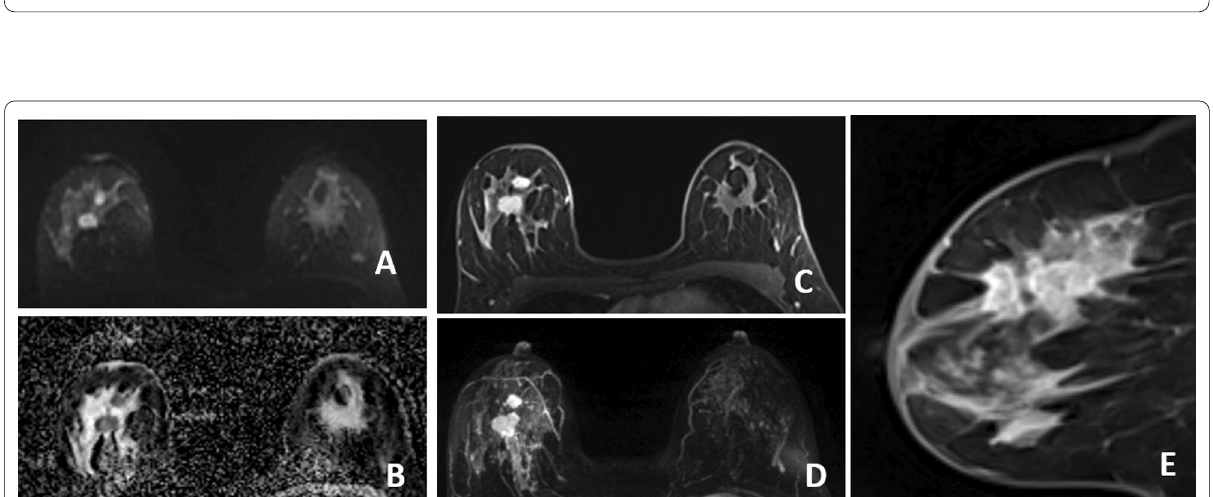
Fig. 2 A 52-year-old female with recently diagnosed left breast LOQ IDC Grade II (Luminal type A) A MRI Wash-in map B , C DWI b value ADC, respectively, showing diffusion restriction ADC value